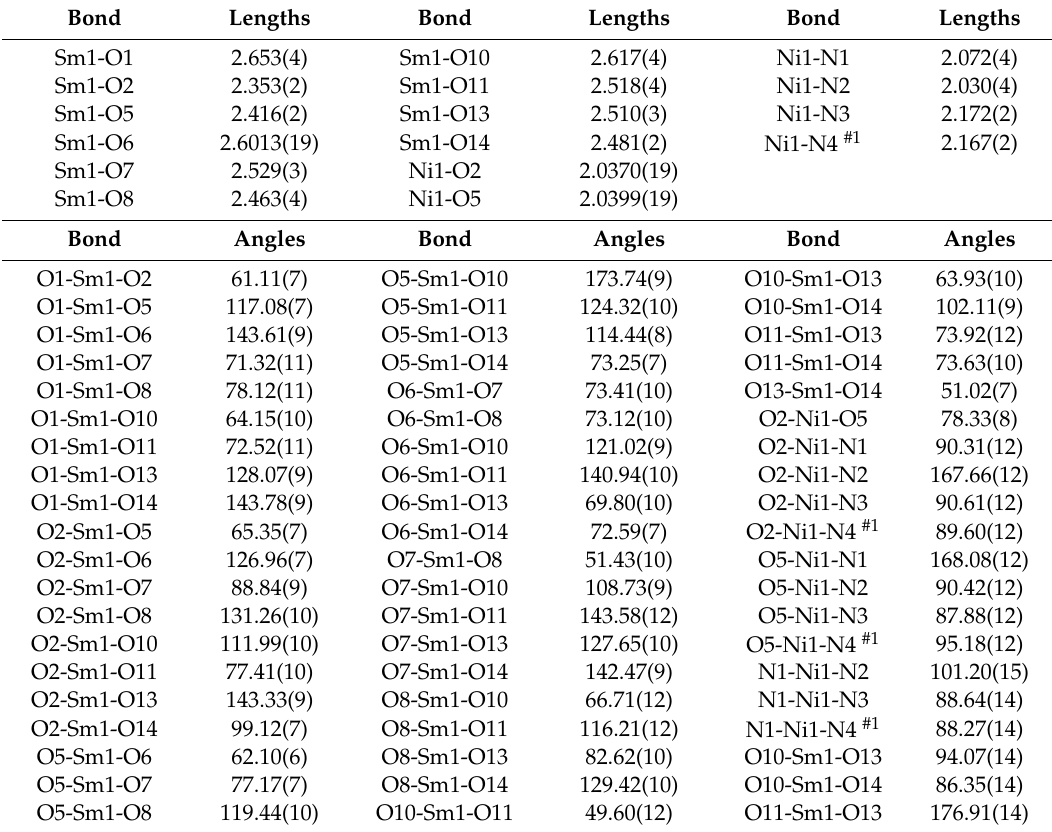
Table 2. Selected bond lengths (Å) and angles (deg) for the title